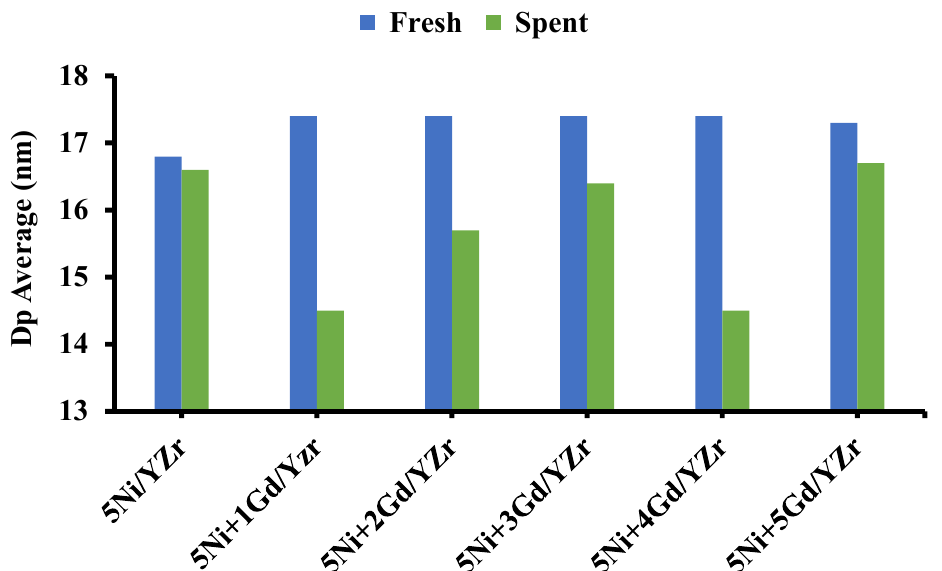
Figure 5. Average crystallite size for the fresh and spent catalysts.